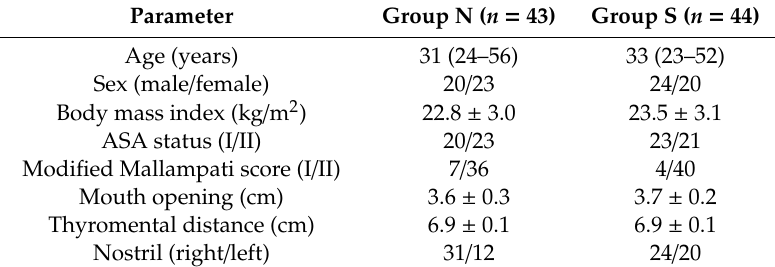
Table 1. Baseline characteristics and preoperative airway assessment.